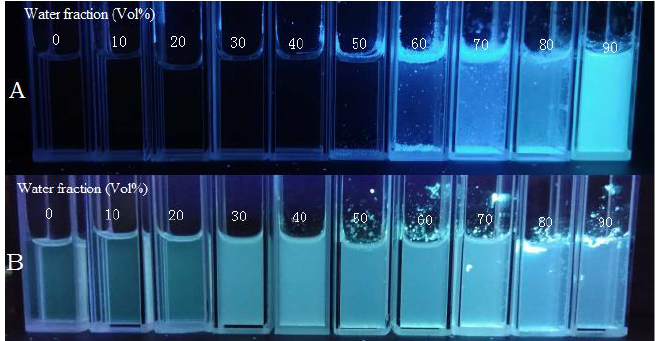
Figure 4. Comparison of fluorescence behaviors of ( A ) TPE (c TPE = 2 mg/mL, 6.0 μmol/mL) with ( B ) nanogel of P(BPMA- co -ProHEMA) gel - b -PMMA (c nanogel = 1 mg/mL, c TPE unit < 0.37 μmol/mL) in THF/water mixed solvents with different water fractions from 0% to 90%. UV light (λ = 365 nm) was used to excite emission.